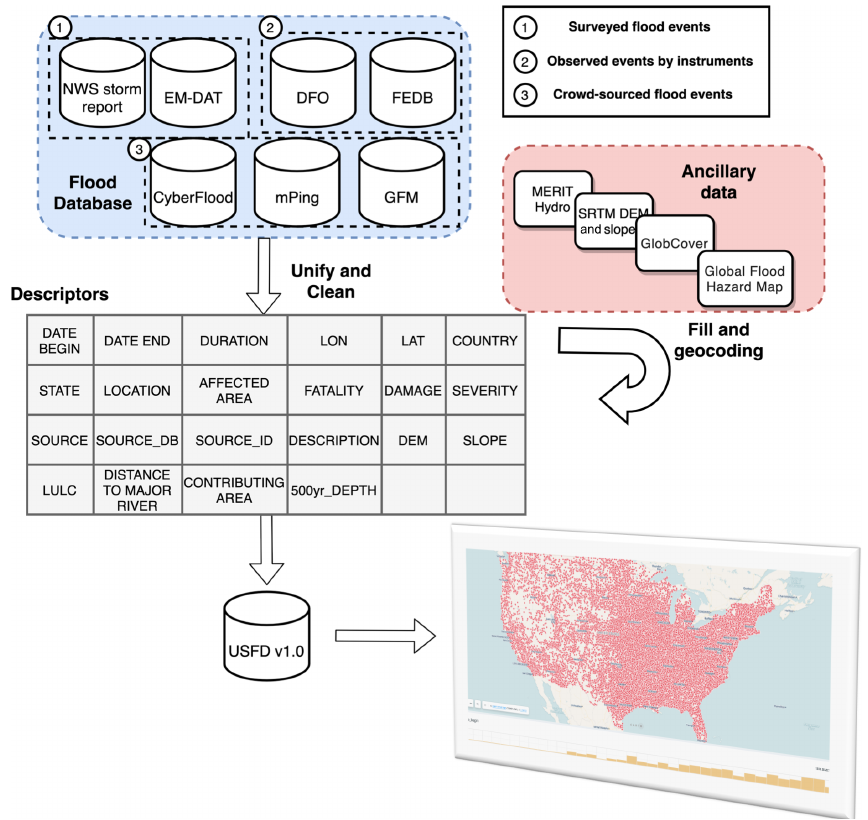
Figure 1. Flowchart of dataset